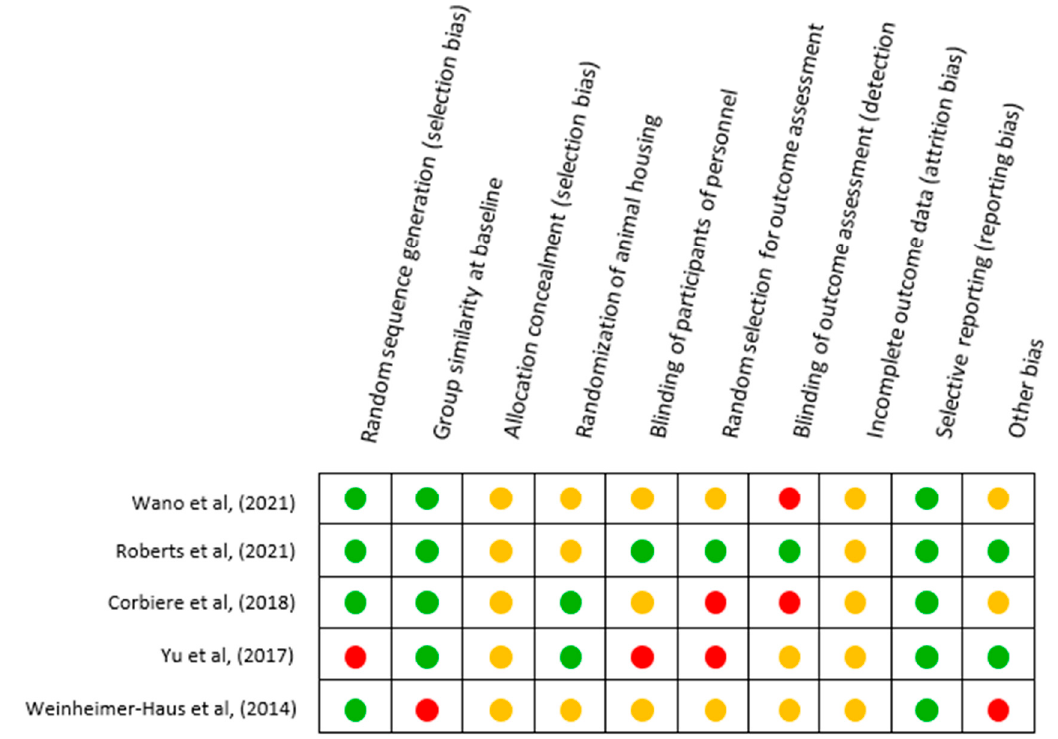
Figure 3. Risk of bias summary shows studies’ quality assessment at an individual level [21,41–44]. (green) Low risk of bias. (red) High risk of bias. (yellow) Unclear risk of bias.